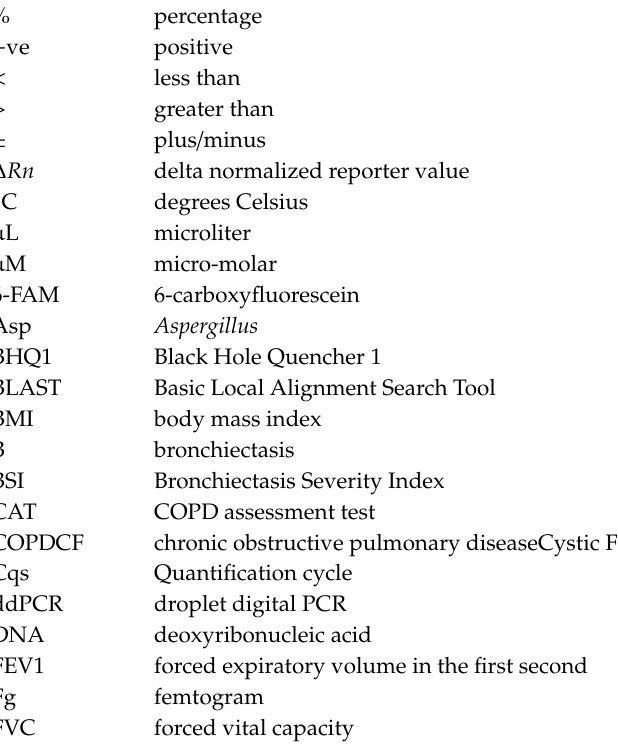
Table S1: MIQE Guidelines: Essential Information